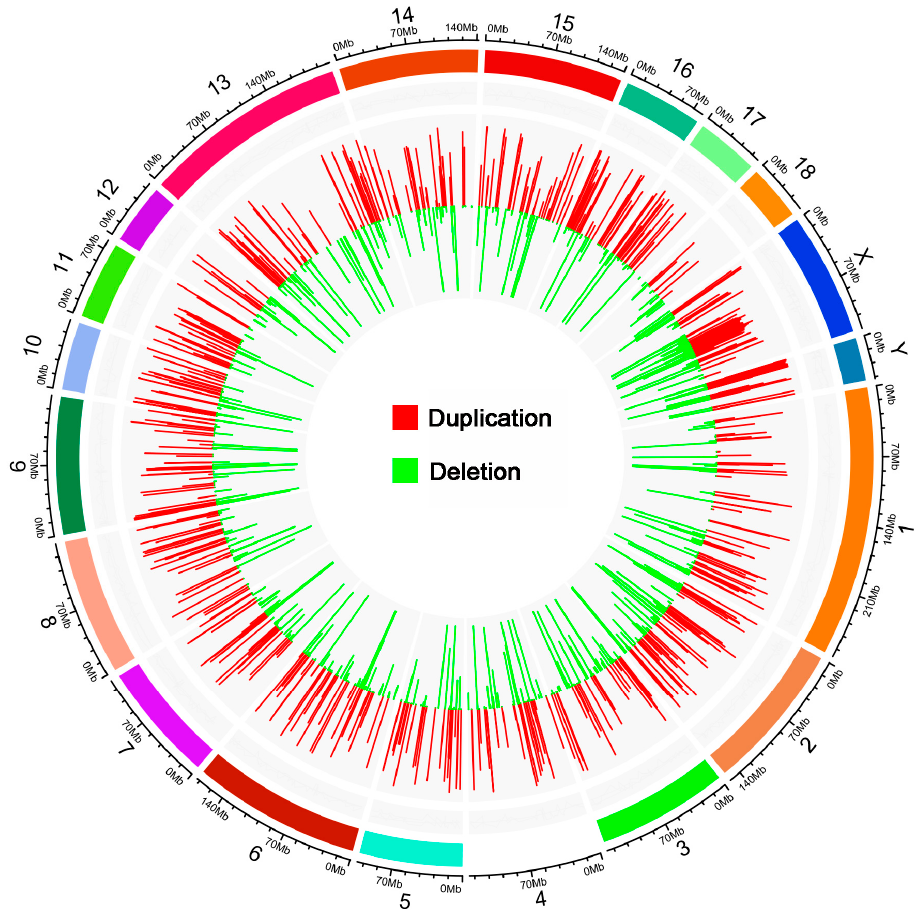
Figure 1. The distribution of pig CNVRs. The outer circle presents the lengths of the chromosomes; the inner circle presents the CNVR distributions. The length of the histogram bars indicates the ratio of different types of CNVRs to the total number of CNVRs.